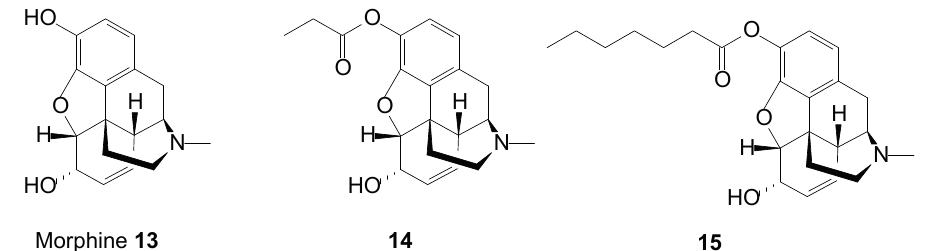
Figure 5. Morphine and its n -alkyl ester